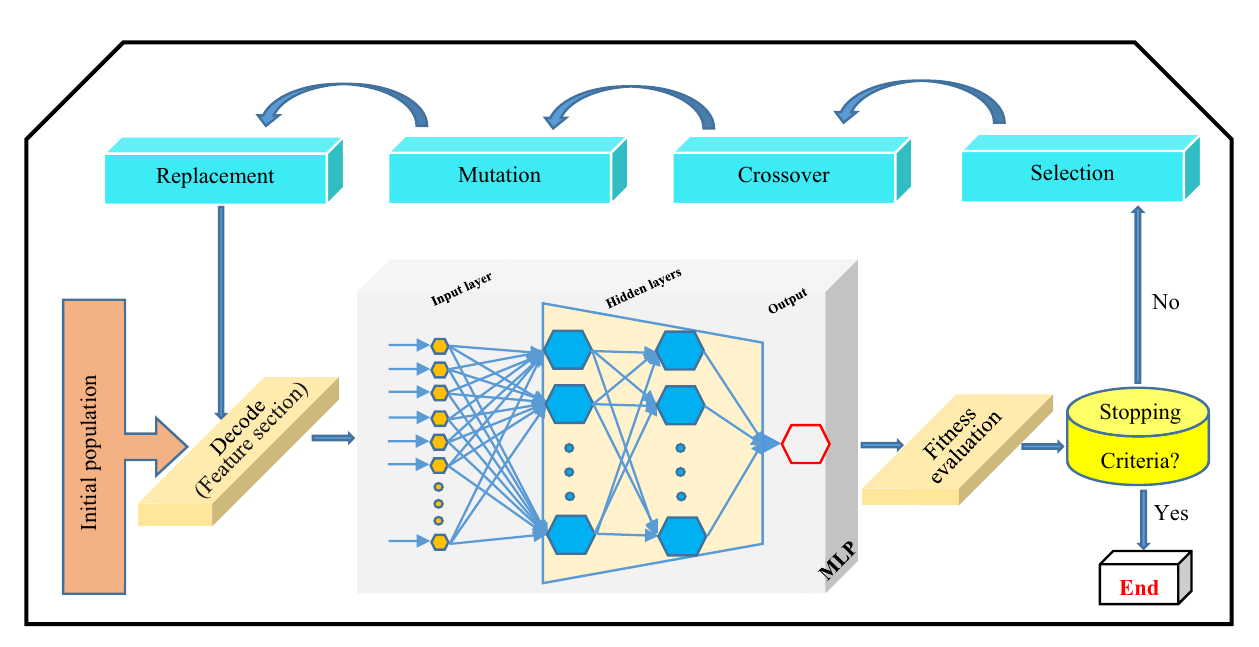
FIGURE 1 | Steps of operation of multilayer perceptron-genetics algorithm (MLP-GA)